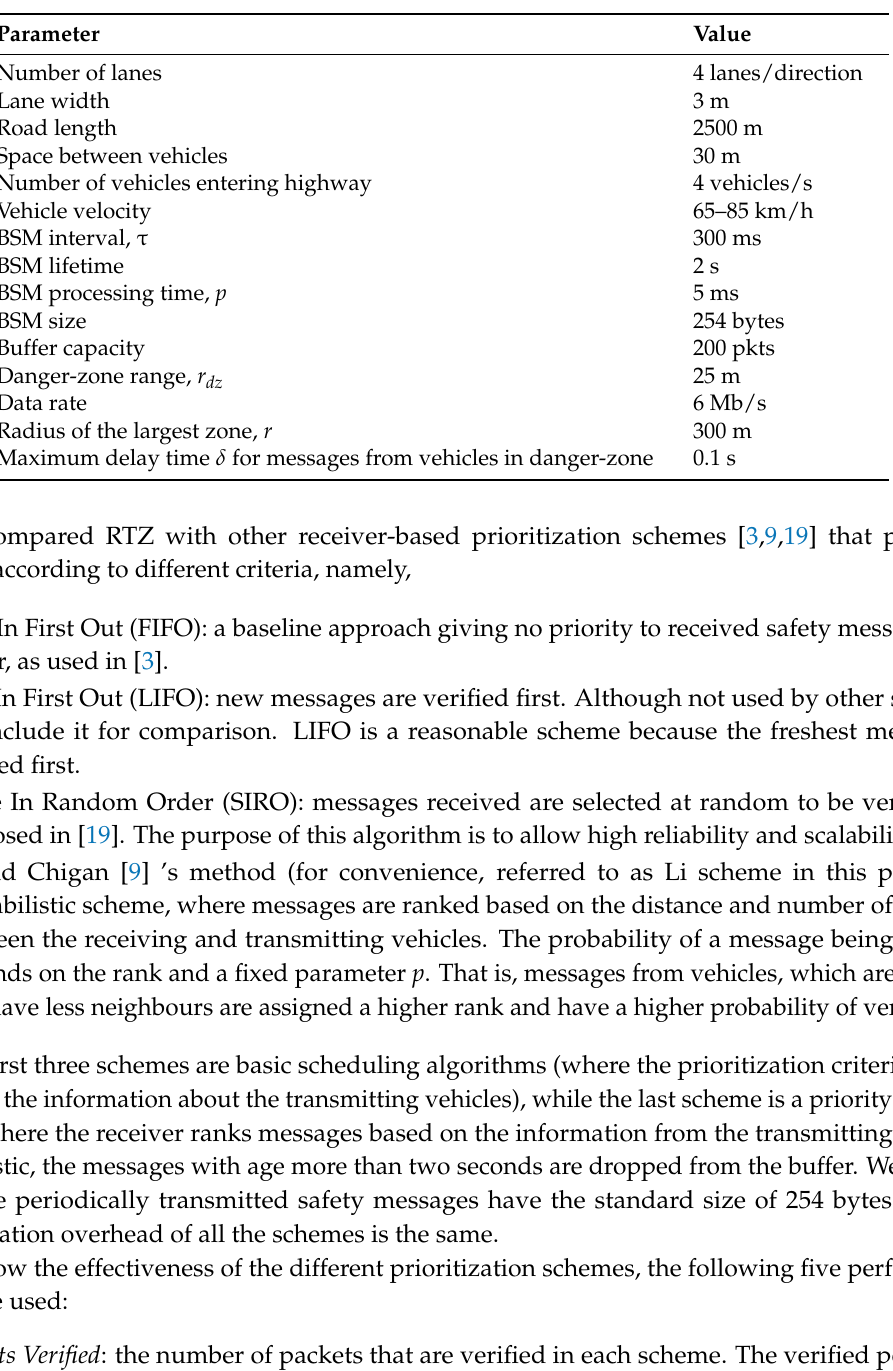
Table 1. Simulation setup